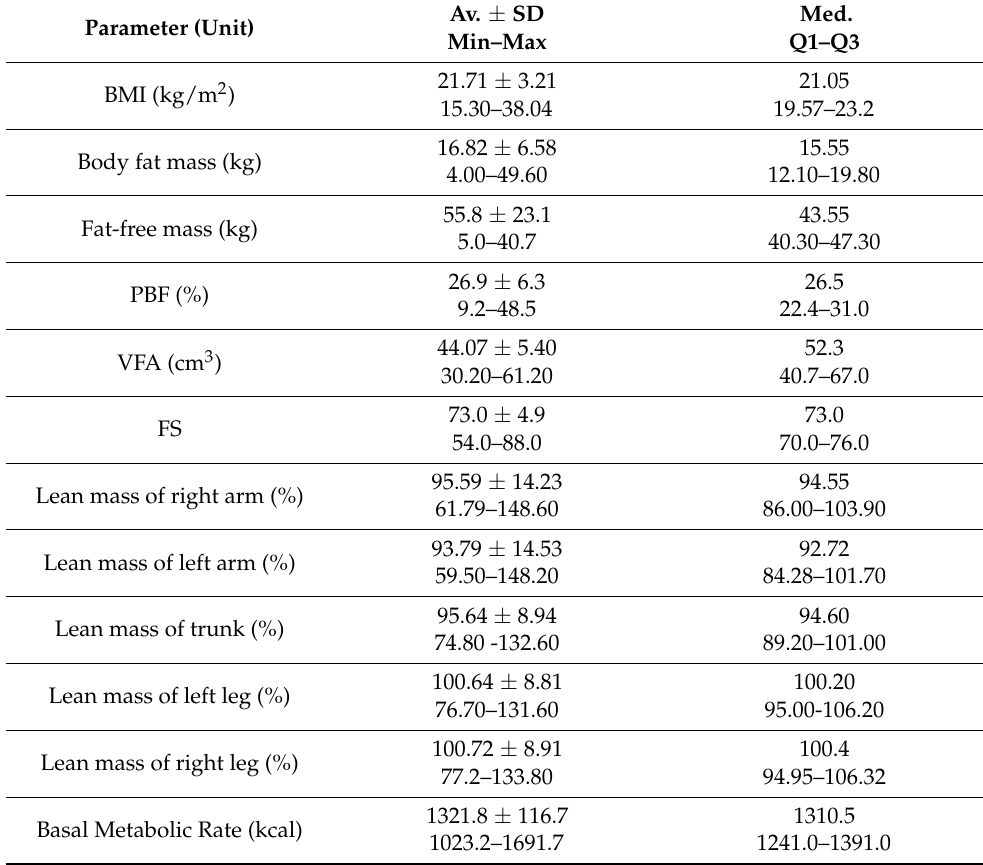
Table 5. Characteristics of the body composition of the studied